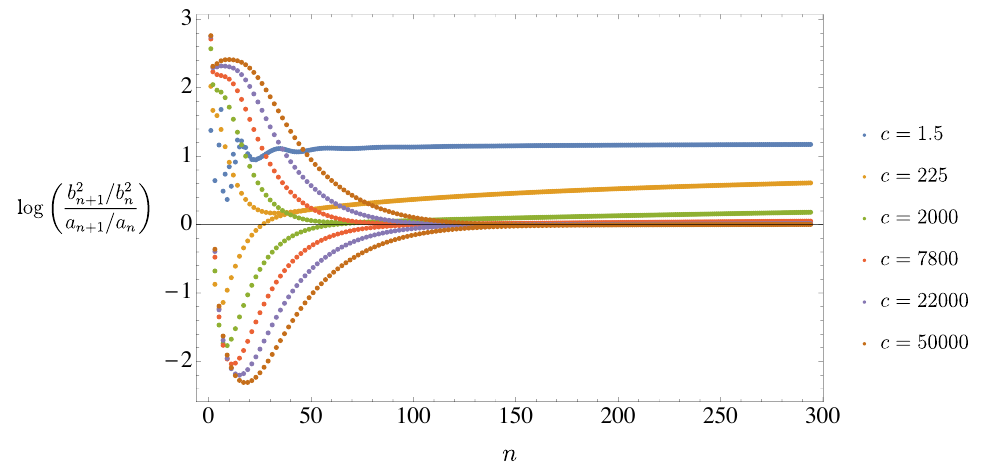
Figure 2 . This plot compares the ratios of successive coe(cid:14)cients in the holomorphic and mixed terms contributing the full propagator. We see that at large c , the coe(cid:14)cients of (cid:26) n grow at the same rate, meaning that the holomorphic propagator provides a good estimate for the behavior of the full